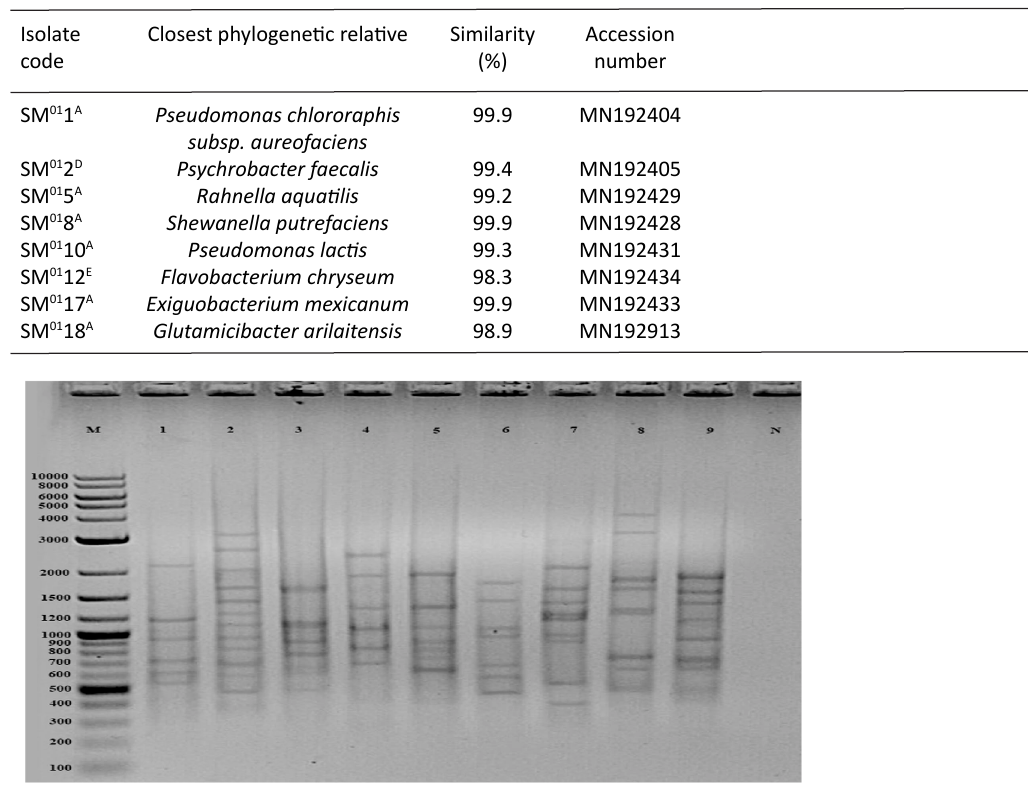
Table 1. 16S rRNA sequence similarity ratios and GenBank accession numbers